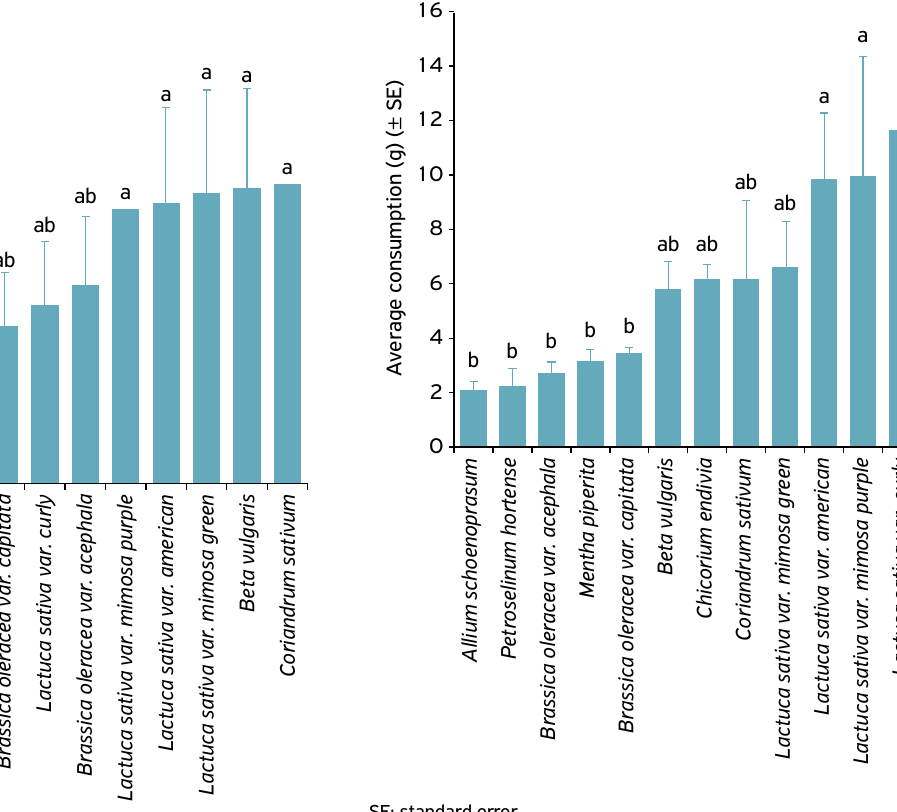
Figure 5. Average number of fresh food consumed by adult Achatina fulica in non‑choice test at laboratory.